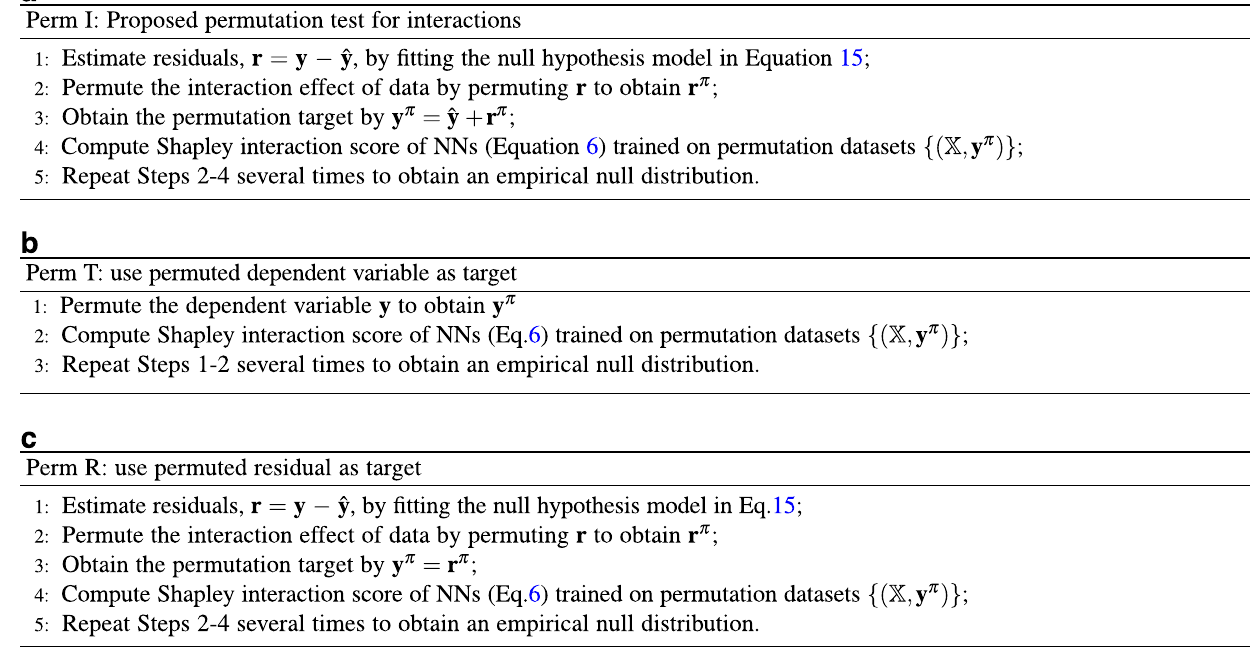
Fig. 8 Permutation algorithms. a The proposed permutation algorithm for interactions (Perm I). b Use permuted dependent variable as target (Perm T). c Use permuted residual as target (Perm